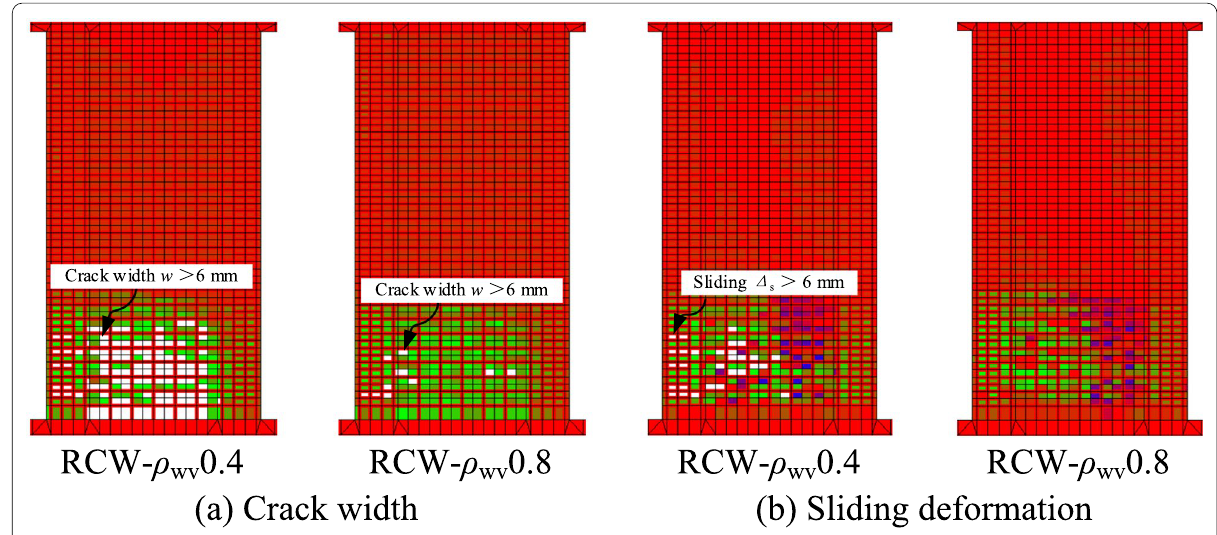
Fig. 16 Crack width and sliding deformation for specimens at 1.0% lateral